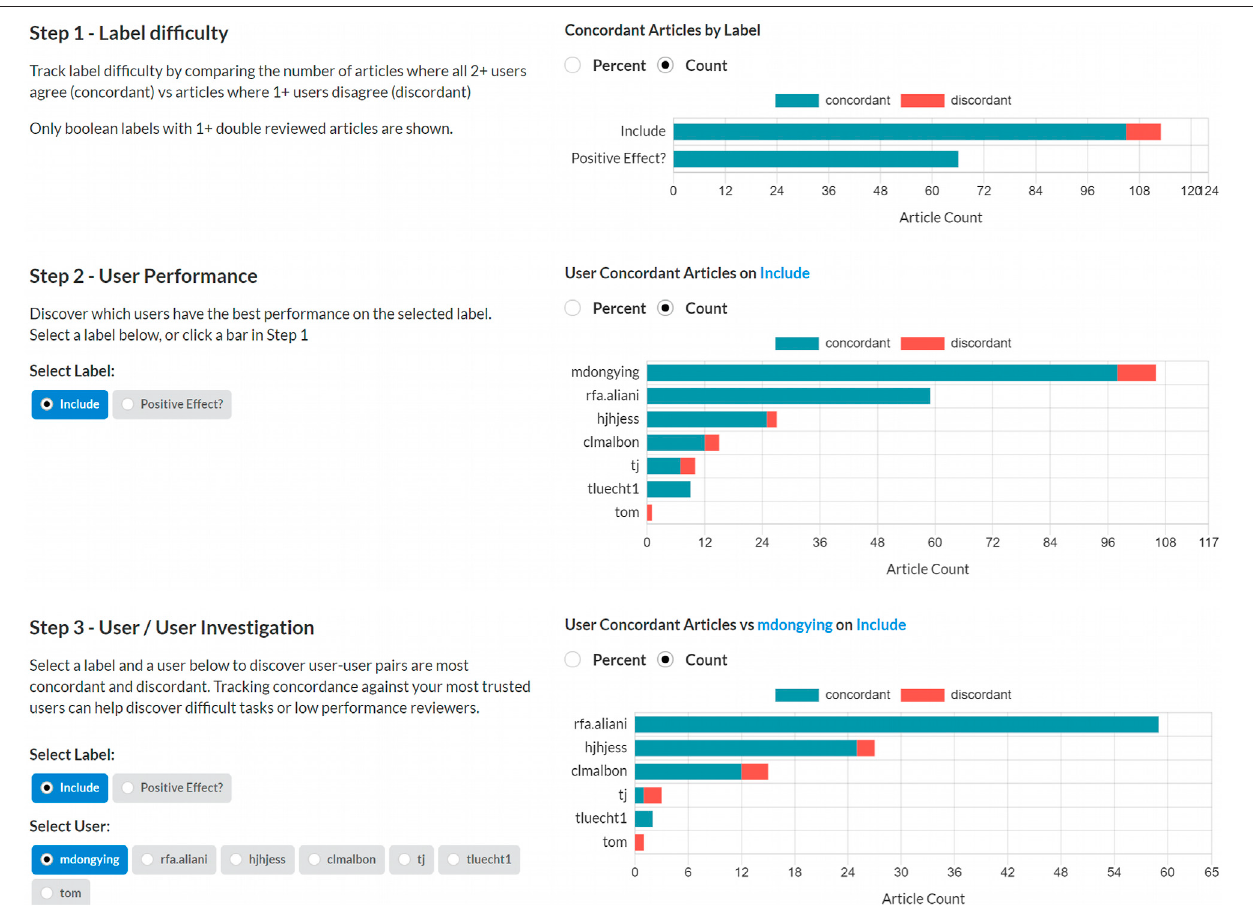
FIGURE 4 | A screenshot of the Sysrev concordance tool in action. This tool can be demonstrated at sysrev.com/p/21696/analytics/concordance.